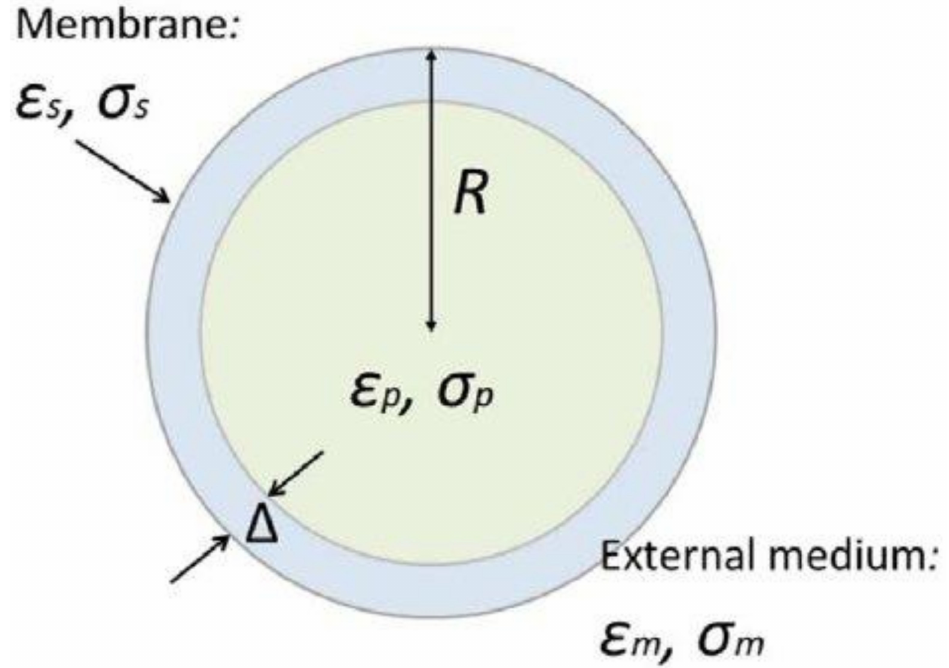
Figure 3. The single-shell model. A spherical particle representing a cell with radius R , permittivity ε p and conductivity σ p , which is covered by a uniform layer of thickness ∆ << R , permittivity ε s , and conductivity σ s . Obtained from the work of Chau et al. [42].